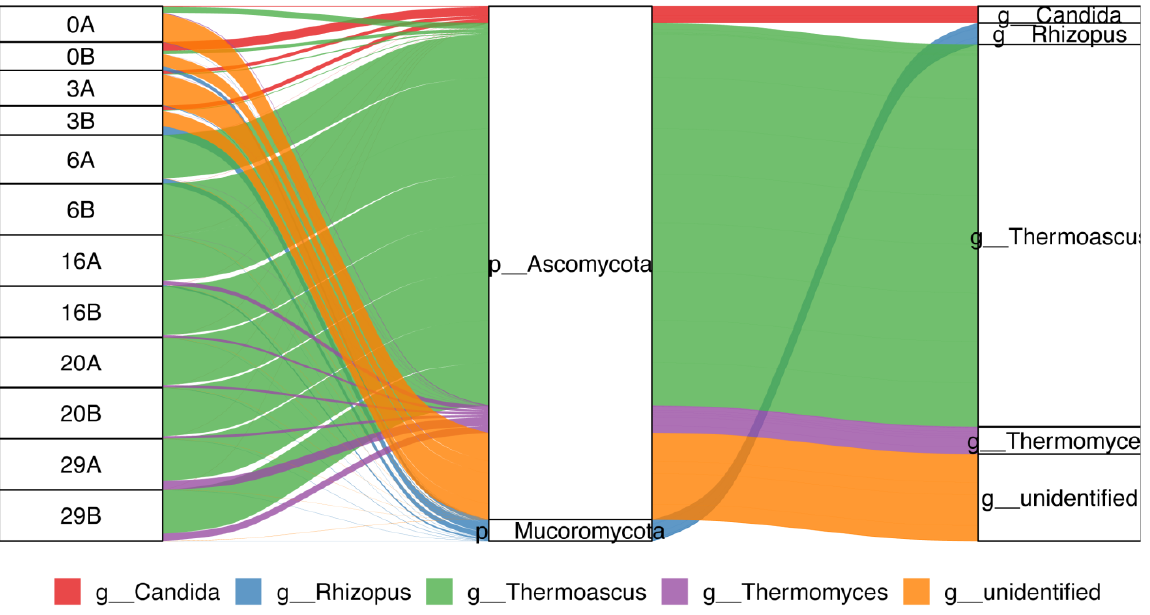
Figure 3. Sankey network diagram of fungal community composition in Daqu (based on amplicon sequencing).